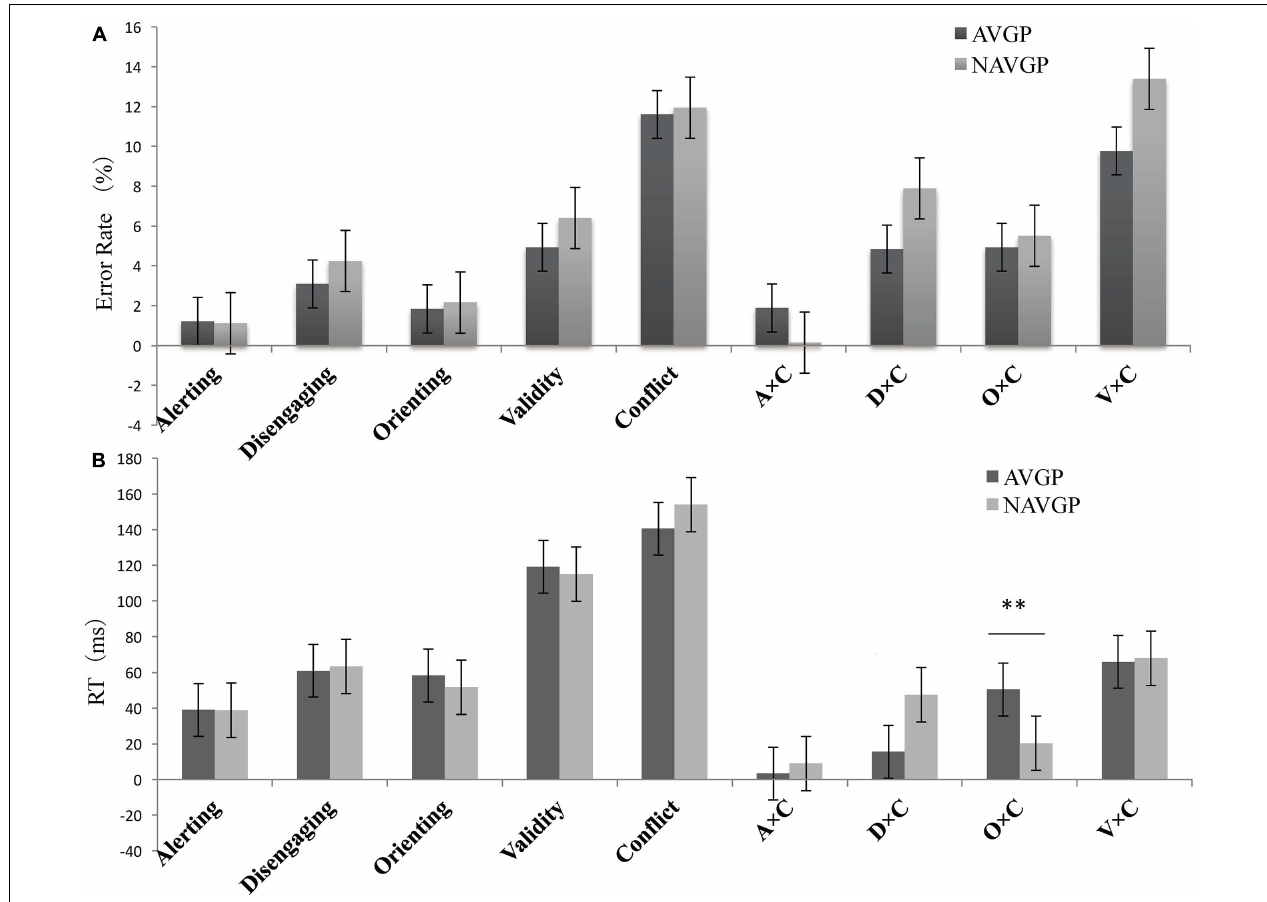
FIGURE 3 | (A) Error rate (ER, %) and (B) Reaction times (RTs) as a function of the attentional effects of different groups in the ANT-V. Error bars represent the standard error of the mean. A × C, alerting by conflict; D × C, disengaging by conflict; O × C, orienting by conflict; V × C, validity by conflict. ∗∗ p < 0.01.